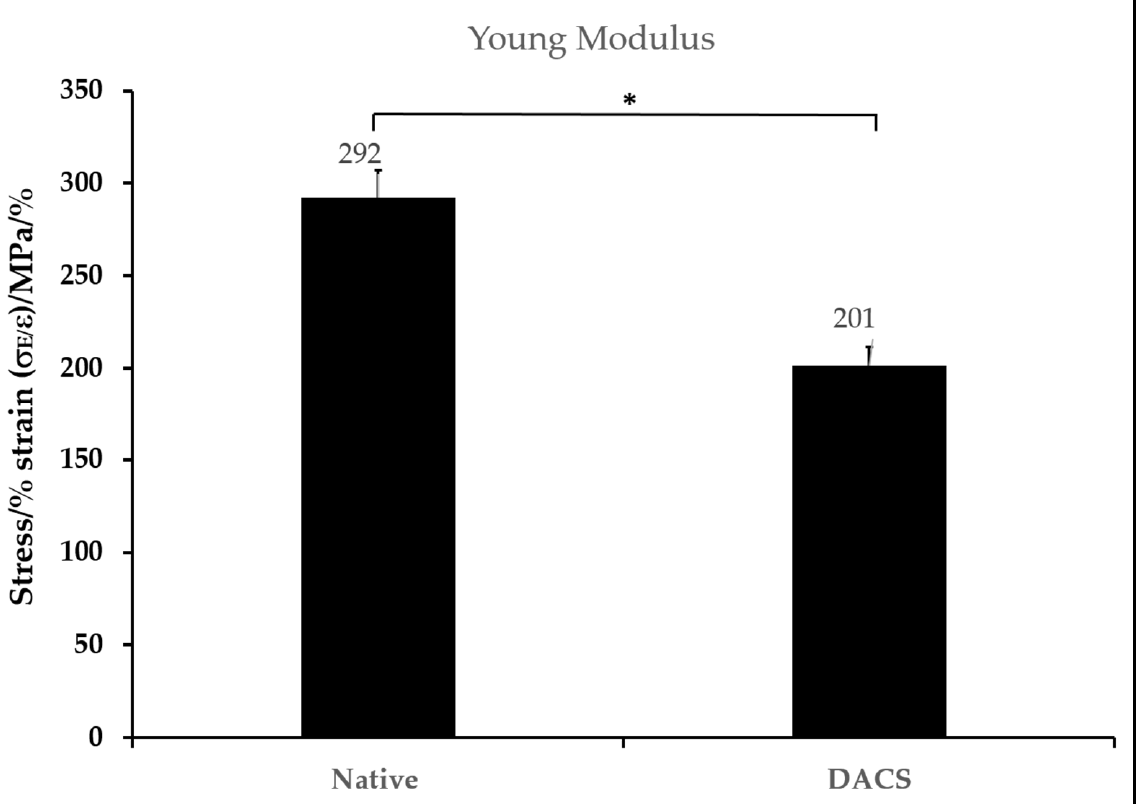
Figure 8. Mean Young modulus of DACS and the Native avian cartilage. Values are reported as mean ± Standard deviation, * p = 0.05, n = 3.